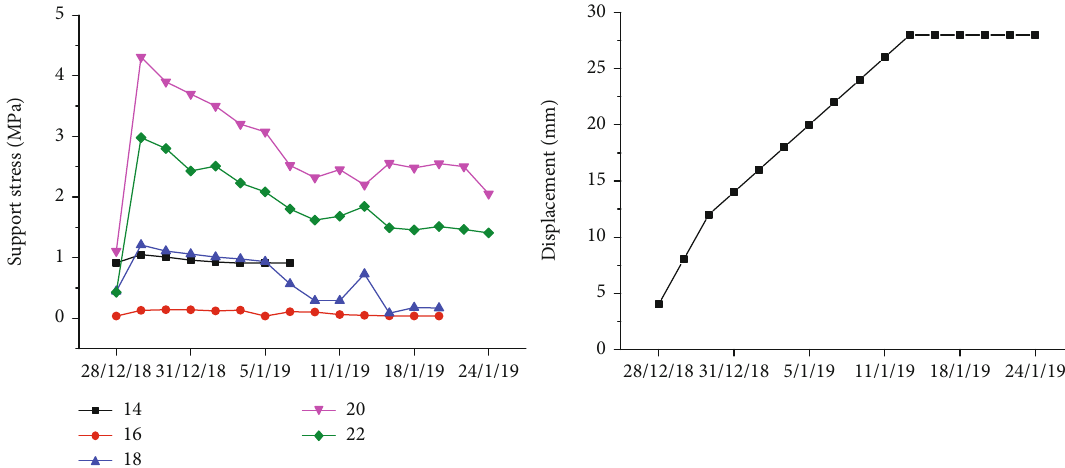
Figure 15: Analysis of monitoring results: support stress and displacement of Section I (E03-Y8+11m).